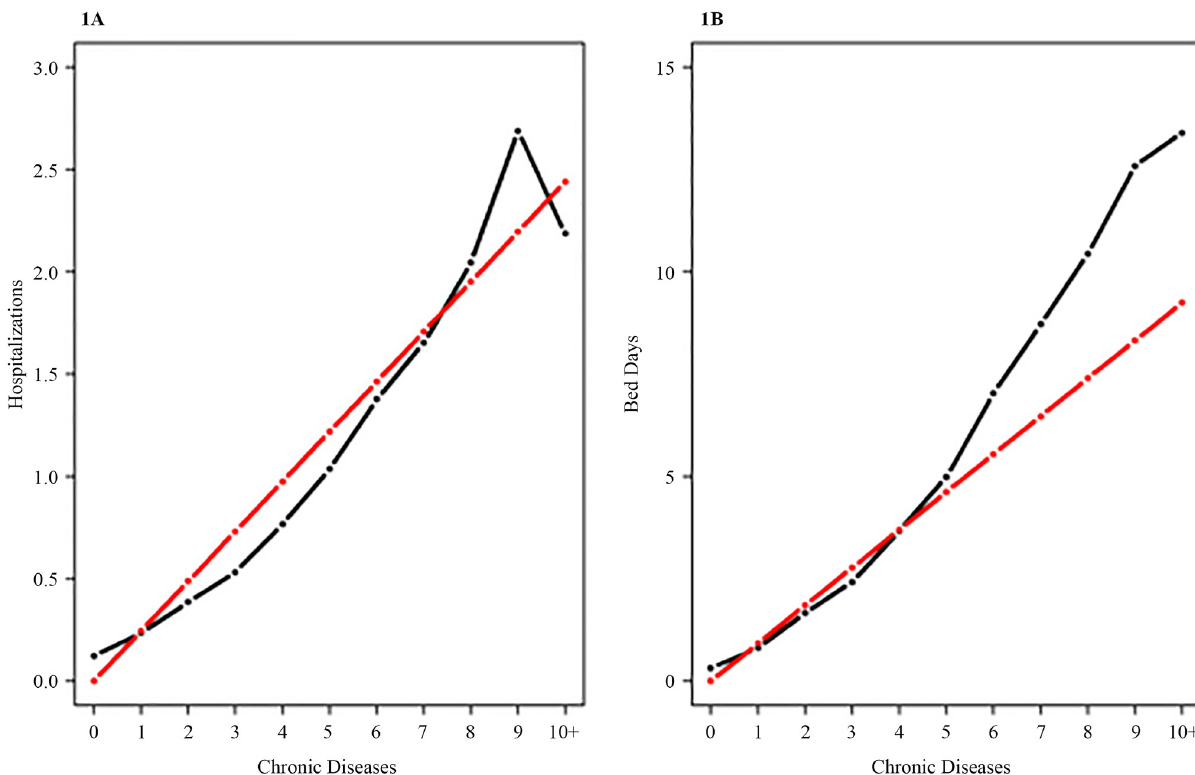
Fig 1. Relationship between numbers of chronic conditions and hospitalizations (1A) and between numbers of chronic conditions and bed days (1B). (1A) The black line indicates the observed number of hospitalizations by the number of chronic conditions. The red line indicates the reference regression line that shows the mean number of hospitalizations multiplied by the number of chronic conditions. (1B) The black line indicates the observed number of bed days by number of chronic conditions. The red line indicates the reference regression line that shows the mean number of bed days multiplied by the numbers of chronic